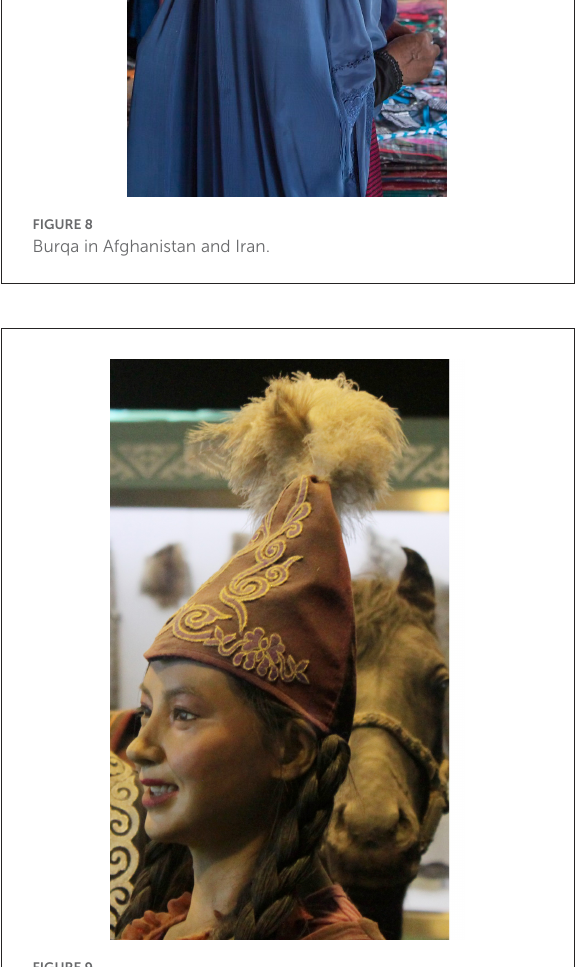
FIGURE9 Conical-type Headdress of the Kazakh.